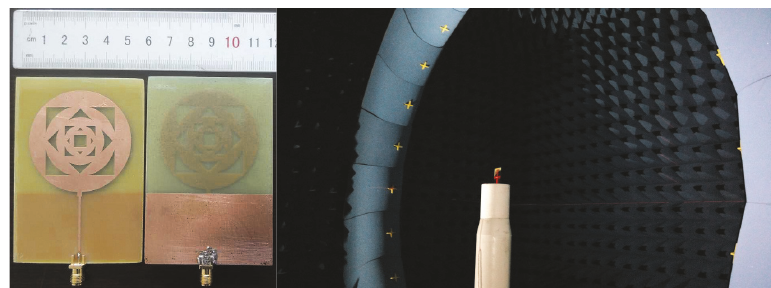
Figure 9: Fabricated antenna prototype and experimental test setup in an anechoic chamber.